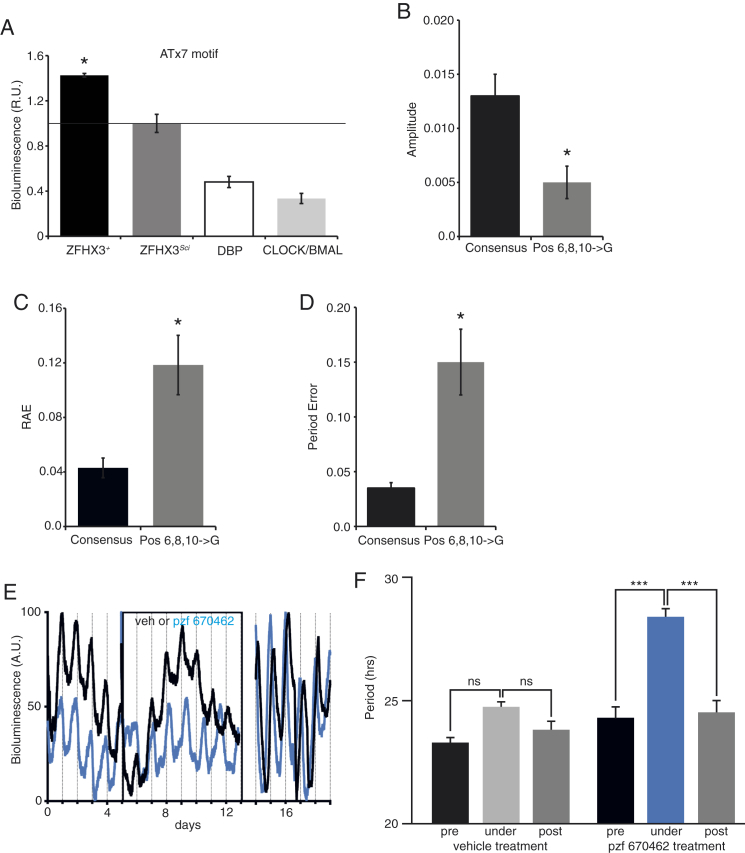
ZFHX3+ Preferentially Activates a Novel, Circadian Motif in SCN, Related to Figure 5(A) In vitro activation of the AT motif by recombinant ZFHX3, DBP, or combined CLOCK and BMAL using a luciferase reporter construct driven by the AT motif (×7) in HEK293 cells. Zfhx3+ activation of the AT motif was more than 3 times that seen for either DBP or CLOCK/BMAL (p < 0.05, t test). Activation of AT sequences in SCN slices transduced by LVs showed cyclic activation in SCN slices from Zfhx3+/+ animals (Figures 5B and 5C).(B–D) Mutations of the three most conserved residues (positions 6, 8, 10) in the AT motifs strongly reduced AT activation rates (gray bars) when compared to the AT consensus (black bars). This effect was quantified by measuring both the (B) amplitude and robustness of these oscillations, (C) relative amplitude error, and (D) period error (p < 0.05, t test).(E) SCN slices expressing the AT-luciferase reporters were treated with pzf 670462 1 μM (blue lines) or vehicle (black lines), respectively.(F) Period of AT-mediated oscillations was significantly lengthened by pzf 670462 (p < 0.001, 2-way ANOVA repeated-measures), whereas it was unaffected by vehicle treatment. This effect was reversible upon removal of the drug.